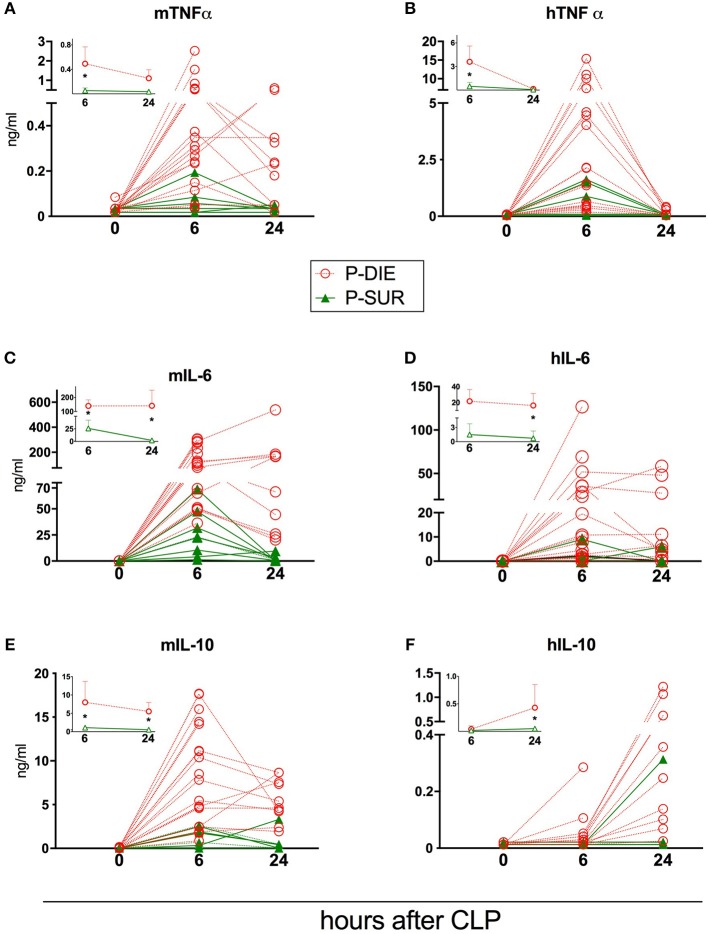
Comparison of human and murine cytokines depending on the post-CLP outcome in humanized mice. (A) murine TNF; (B) human TNF; (C) murine IL-6; (D) human IL-6; (E) murine IL-10; (F) human IL-10. (P-Die n = 23, P-Sur n = 8). Insets present a comparison of P-DIE (n = 22) vs. P-SUR mice (n = 9). Data are presented as mean values and 95% confidence interval bars. Concentrations of cytokines of P-SUR and P-DIE mice were compared by the t-test at each time-point separately. *p < 0.05.